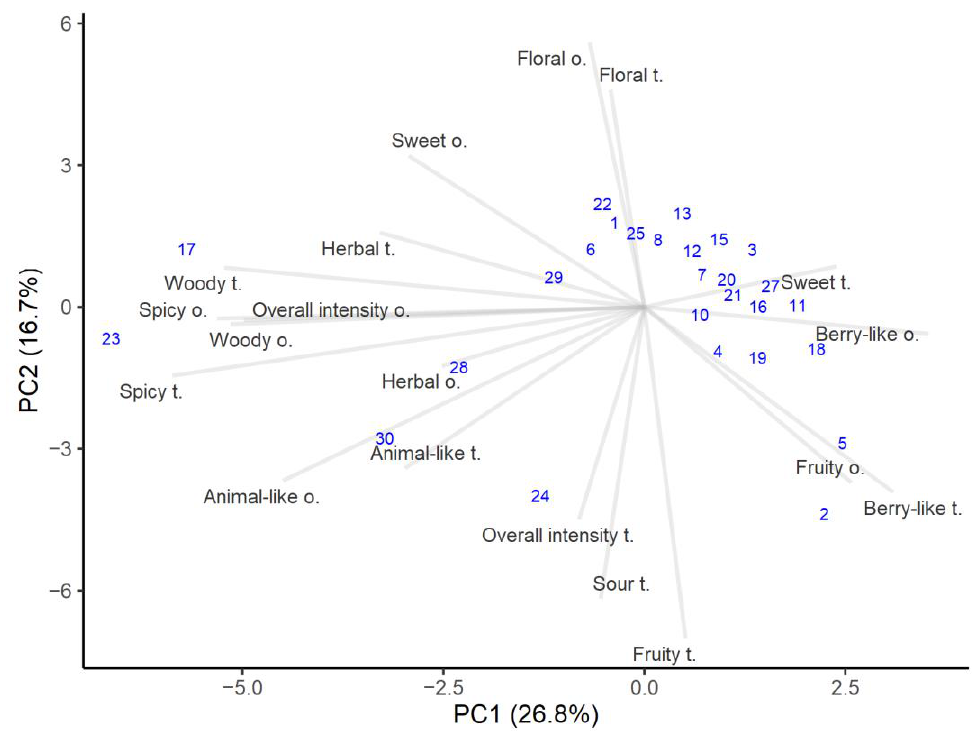
Figure 2. PCA analysis of the sensory attributes of honey samples. The number in parenthesis shows variance explained by the principal